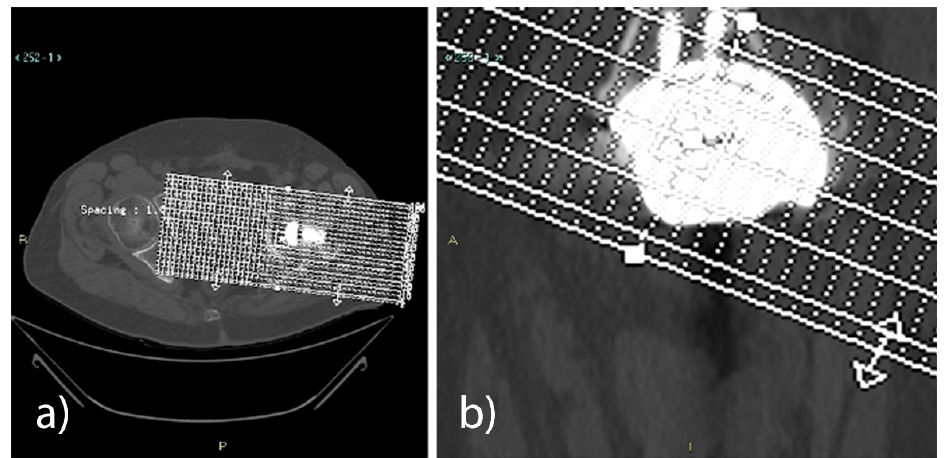
Figure 2. ( a ) Axial and ( b ) coronal CT views for bone gap measurement.